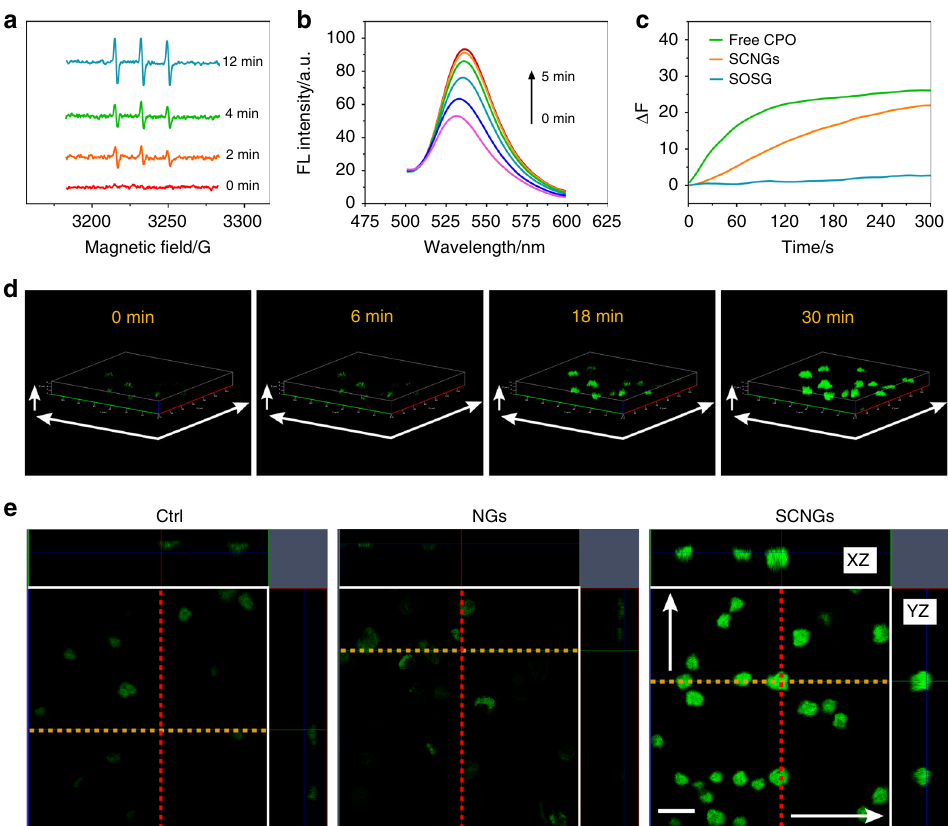
Fig. 3 Characterization of the generation of 1 O 2 . a Time-dependent electron paramagnetic resonance (EPR) signals of 1 O 2 from SCNGs in the presence of 2,2,6,6-tetramethylpiperidine (TEMP). TEMP was served as a 1 O 2 trapper. b Fluorescence spectra of the singlet oxygen sensor green (SOSG) with SCNGs in PBS buffer (20 mM, pH 6.8). c Time-dependent fl uorescence spectra of SOSG with free CPO and SCNGs in PBS buffer (20 mM, pH 6.8). a.u., arbitrary units. d Three dimensional confocal laser scanning microscopy (3D-CLSM) images of living HepG2 cells after co-incubation with SCNGs at 300 μ g mL -1 for 2 h and treated with SOSG probe (5 µ M) from 0 min to 30 min. Scale bar, X -axis: 140 μ m, Y -axis: 140 μ m, Z -axis: 12 μ m. e The corresponding CLSM photomicrograph with YZ (cells on the red line) and XZ (cells on the orange line) planes of living HepG2 cells and cells after co-incubation with NGs and SCNGs at 300 μ g mL -1 for 2 h and treated with SOSG probe (5 µ M) at 18 min. Scale bar, 20 μ m. Source data are provided as a Source Data fi